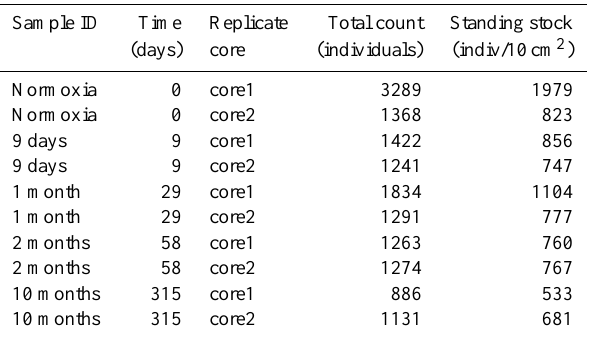
Table 3. Total counts and standing stocks at every sampling time for every replicate